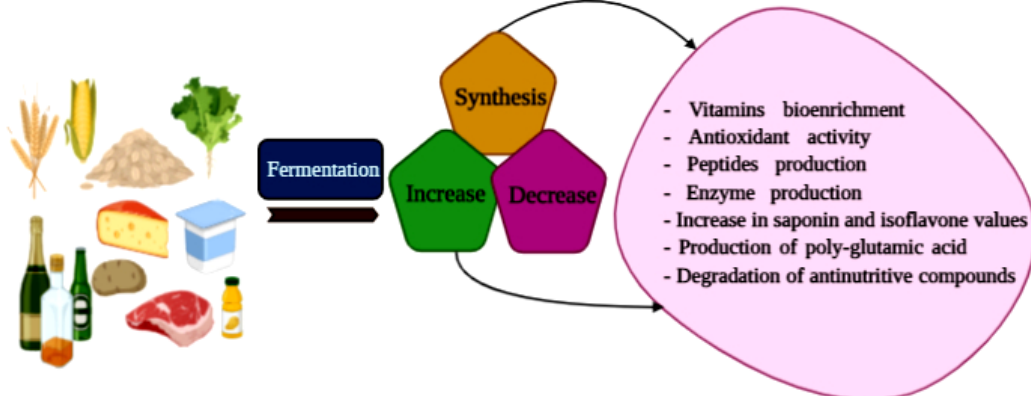
Figure 2. Nutritional enhancement in fermented foods.